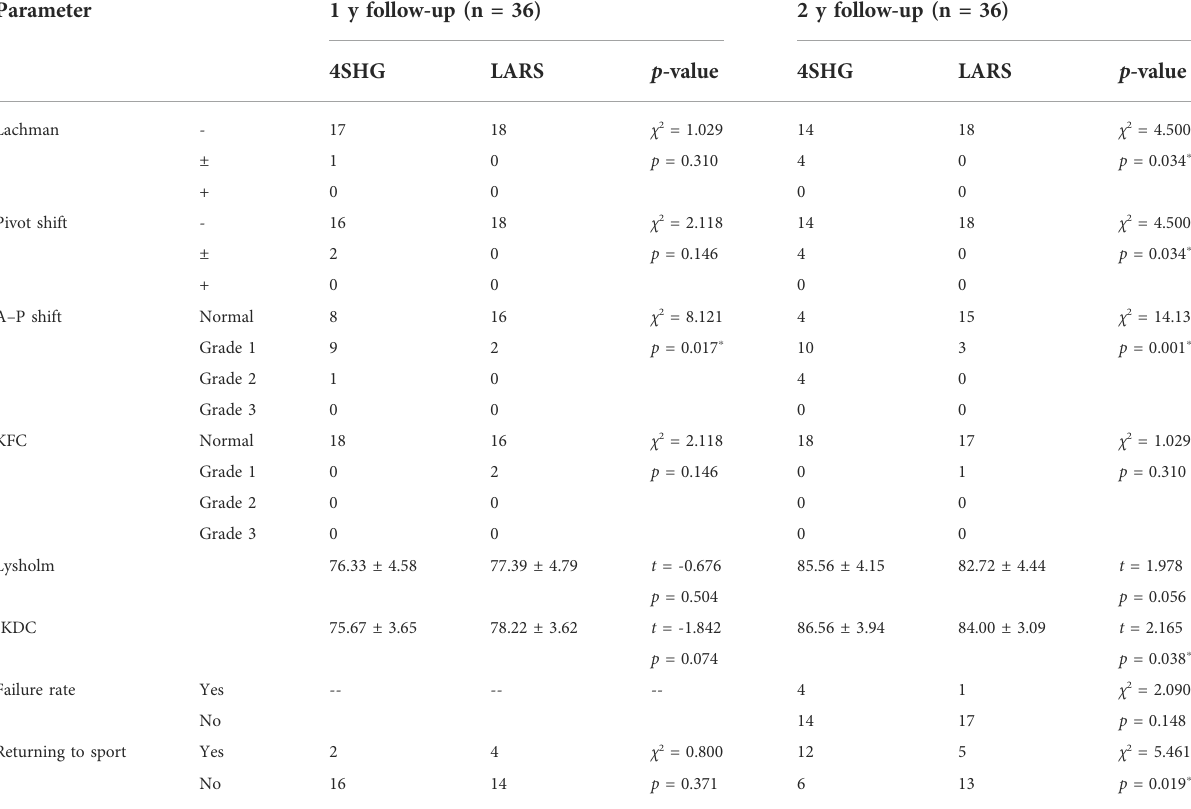
TABLE 3 Comparisons of ef fi cacy, safety, and functional outcomes between the 4SHG and LARS subgroups in plain PAL patients.